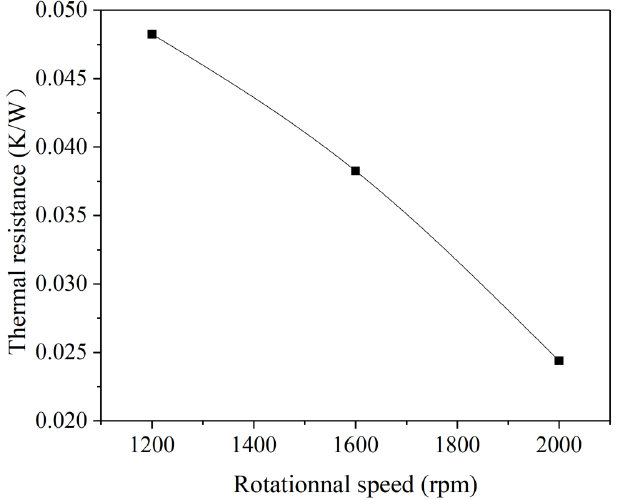
Figure 13. Thermal resistance under different rational speed.